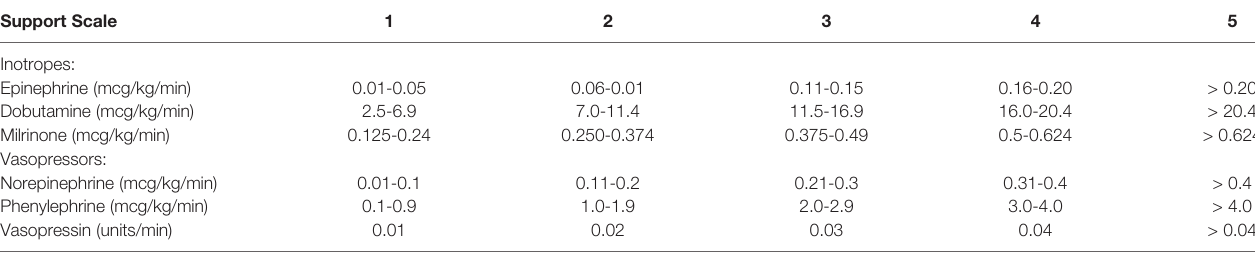
TABLE 1 | Objective Quanti fi cation of Support Postoperatively-ionotropic and vasopressor support required in the fi rst 24 hours after transplantation was quanti fi ed by the following 1-5 scale, with additive scores for each drug used for 0, 1, 12 and 24 hour time points. Support